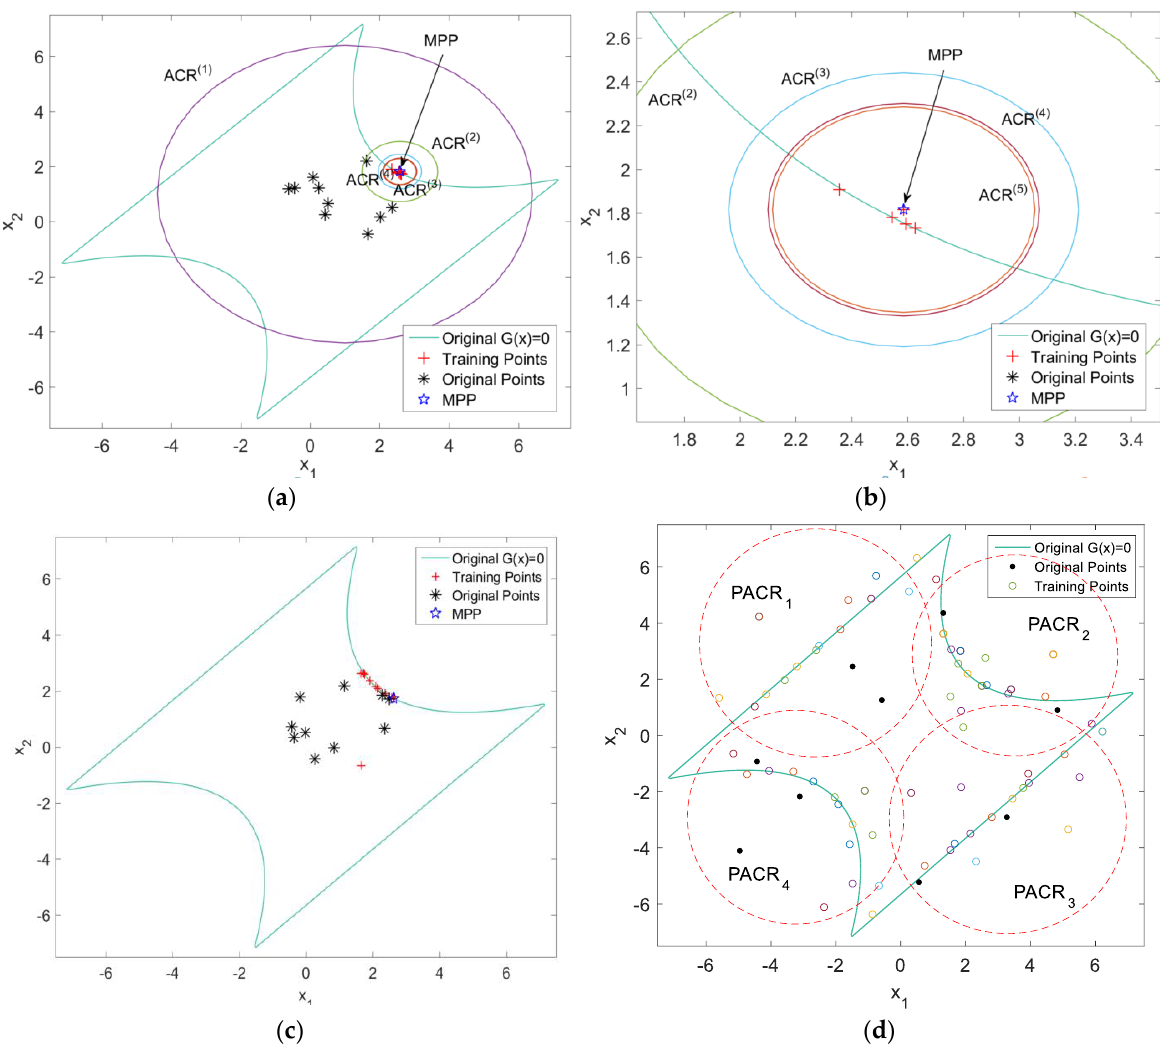
Figure 3. Search history of MPP for the four branches case by ( a ) AIC β = 1.8, ( b ) shows the figure of zooming on the AIC regions. ( c ) The results without AIC method. ( d ) Shows parallel total training by PAIC (ACR means the active candidate region in AIC methods).